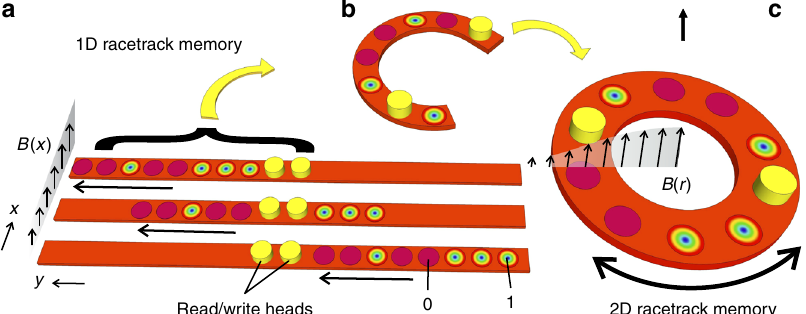
Fig. 1 Circular skyrmion racetrack memory concept. a In the 1D skyrmion racetrack memory scheme, a skyrmion ensemble that encodes the information via the presence (1) or absence (0) of a skyrmion, is moved collectively in a shift register fashion. The skyrmions are written or read-out using local probes 20,21 , current-based injection elements 14,33 , or magnetoresistance elements based on the topological Hall effect 34 . For accessing every memory bit, the entire information stream has to be moved across the read/write head elements. b Morphing half of a 1D strip into a circular structure is the basis for the patterned 2D racetrack memory element shown in c . Here, the required rotation is controlled via an applied magnetic fi eld